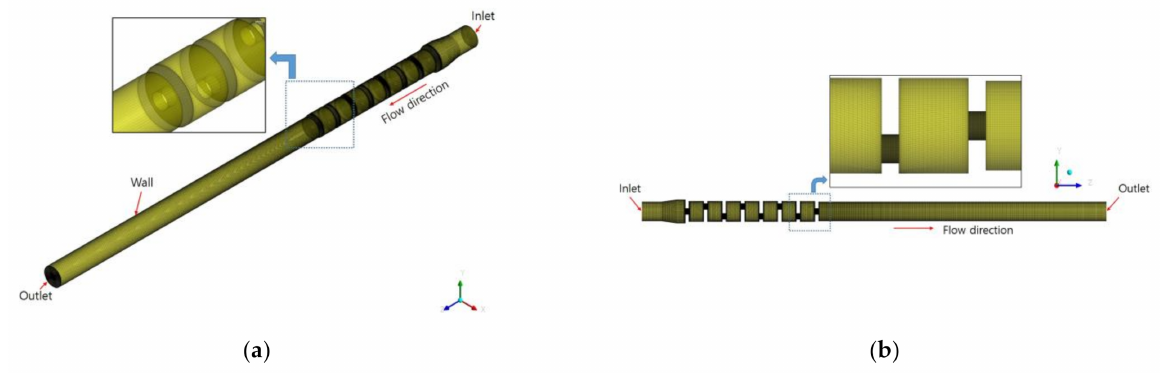
Figure 7. Grid system for eight-stage orifice: ( a ) isometric-view and ( b ) x -axis